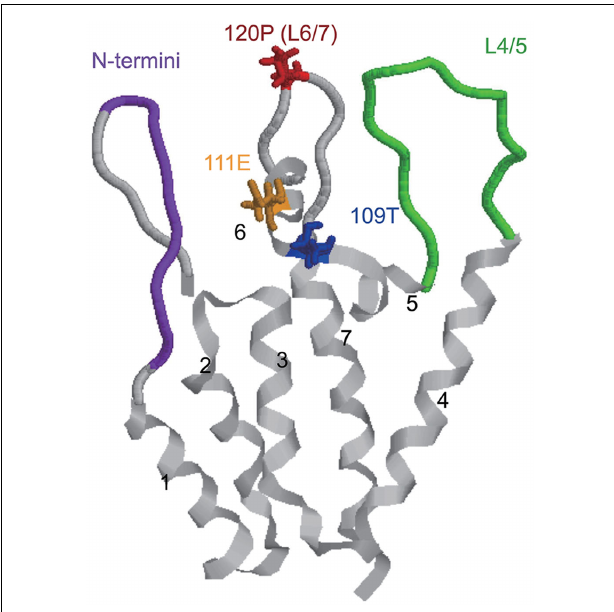
FIGURE 5 | Structure of the N-terminal half of HIV-2 capsid monomer. The ribbons represent the backbone of HIV-2 capsid proteins, and seven α -helices are labeled.The positions important in Rh-TRIM5 α recognition are highlighted as N-termini (the 5th to 13th amino acid residues) in purple, the loop between α -helices 4 and 5 (L4/5) in green, the 109thT in blue, the 111th E in orange, and the 120th P in